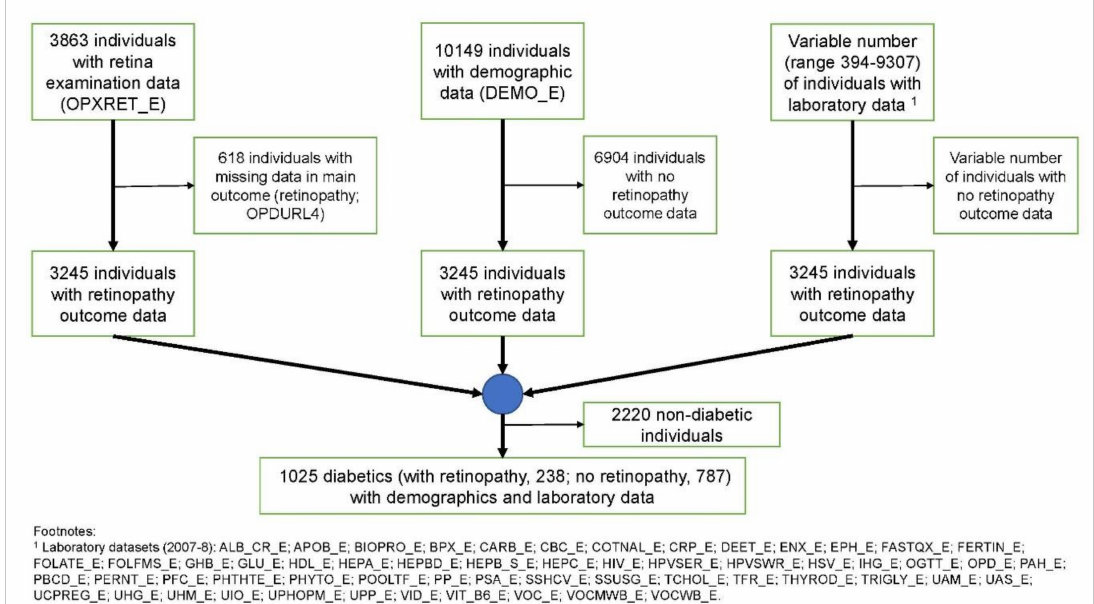
Figure 1. Cohort selection process for the National Health and Nutrition Examination Survey (NHANES)